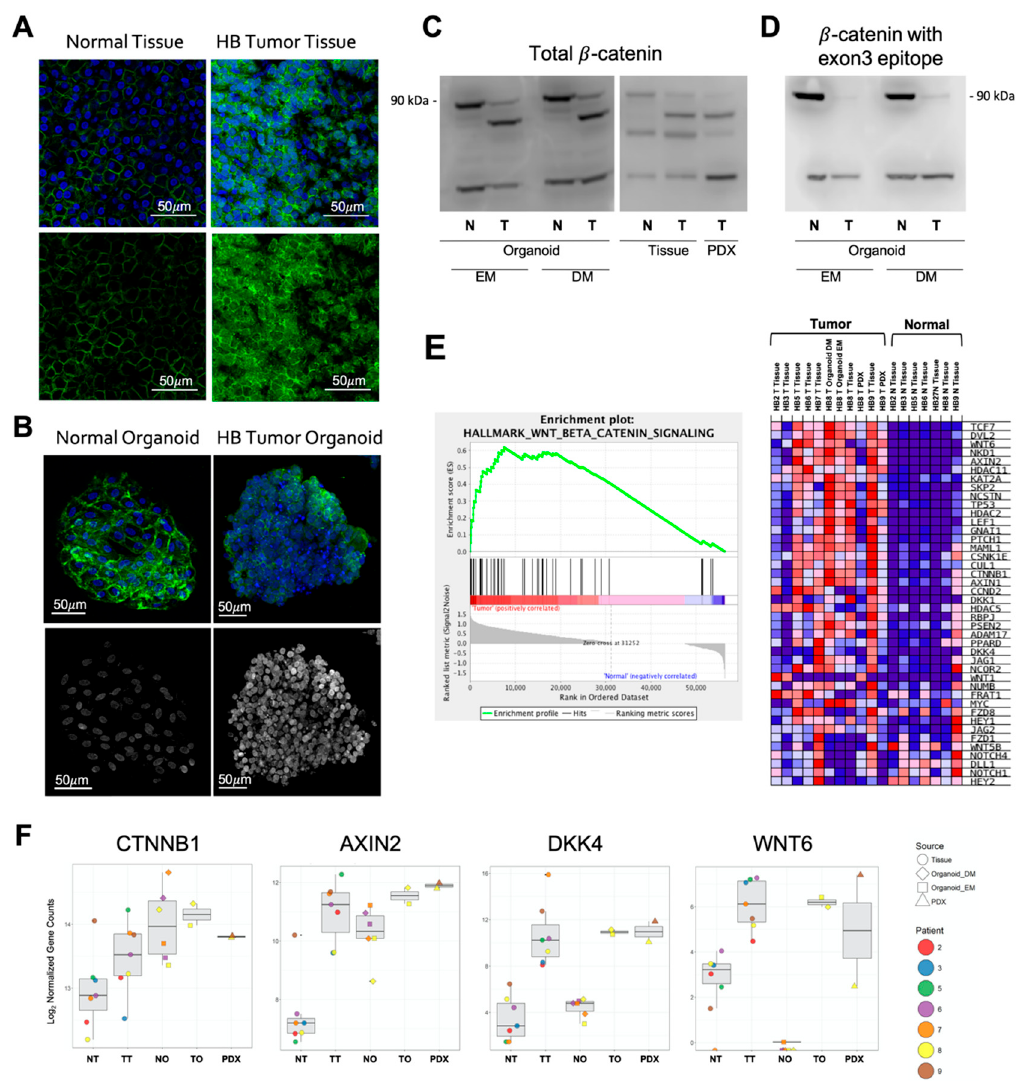
Figure 4. ( A , B ) Immunofluorescence images demonstrate that hepatoblastoma tumor tissue and tumor organoids have greater cytoplasmic and nuclear beta-catenin staining than normal tissue and normal organoids. Green = β -catenin, blue = Hoechst, gray = co-localization. Scale bars = 50 µ m. ( C ) Immunoblot of total β -catenin in normal organoids and tissue shows full length protein at 90 kDa and truncated β -catenin in HB8 tumor organoids, tissue, and PDX associated with large deletion of exon 3. ( D ) Immunoblot of β -catenin using an antibody with an epitope on exon 3 demonstrates the loss of staining in HB8 tumor organoids that harbor an exon 3 deletion. Detail information can be found at Figure S2. ( E ) Gene Set Enrichment Analysis (GSEA) of the Wnt / β -catenin pathway in normal tissue compared to all tumor samples demonstrates a significant increase in the transcription of Wnt / β -catenin signaling genes in tumor samples. ( F ) Wnt / β -catenin gene expression patterns at the single gene level compared between normal tissue (NT), tumor tissue (TT), normal organoids (NO), tumor organoids (TO), and patient derived xenografts (PDX) demonstrate similar expression between tumor tissue and tumor organoid